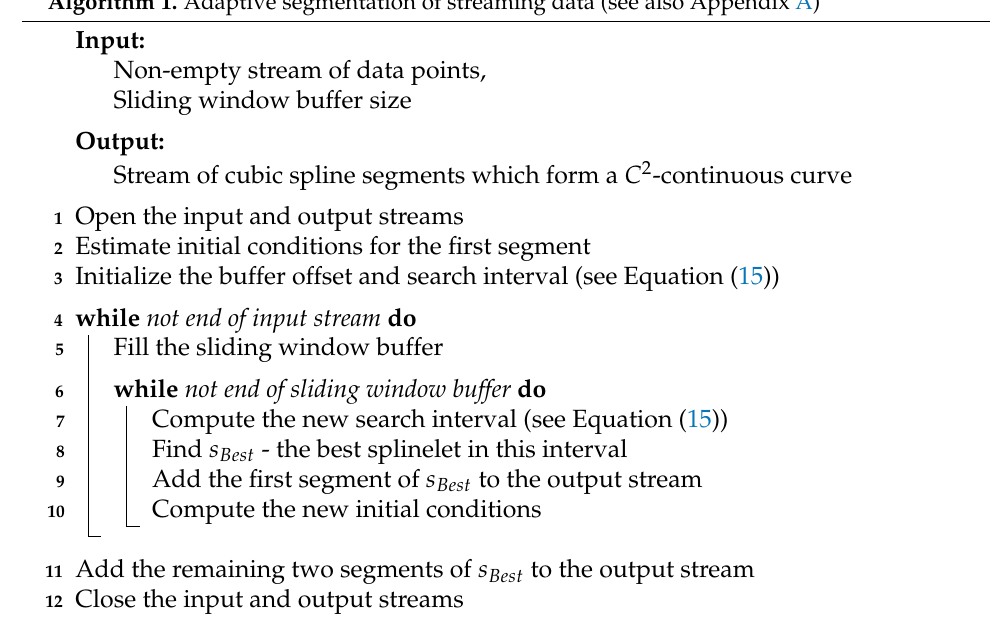
Algorithm 1. Adaptive segmentation of streaming data (see also Appendix